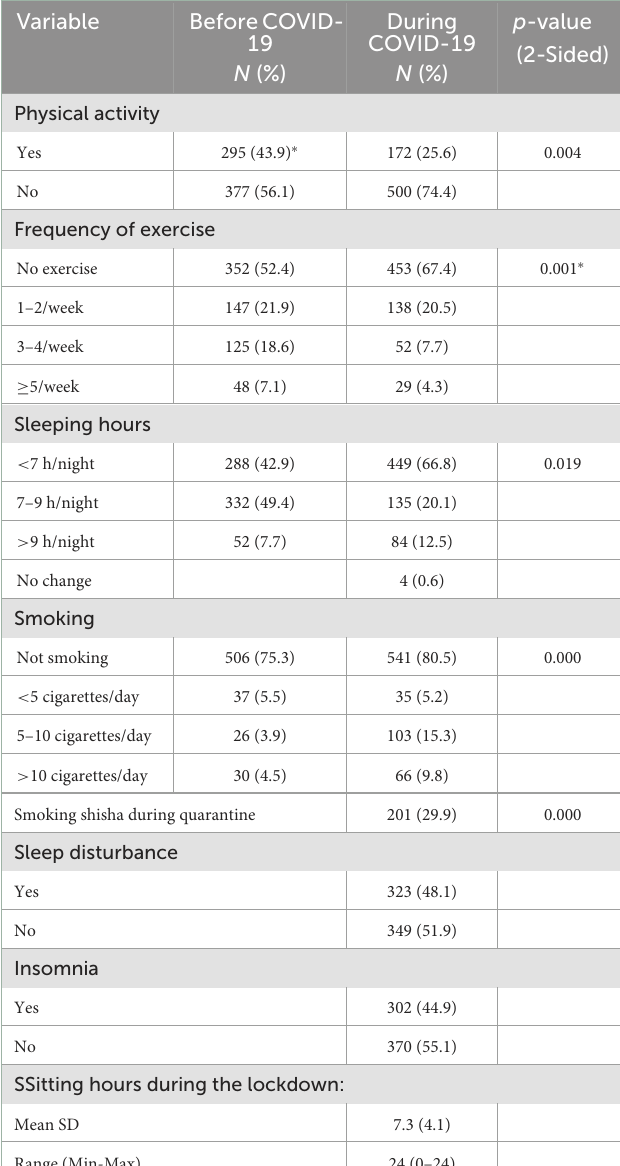
TABLE 2 Lifestyle characteristics before and during COVID-19